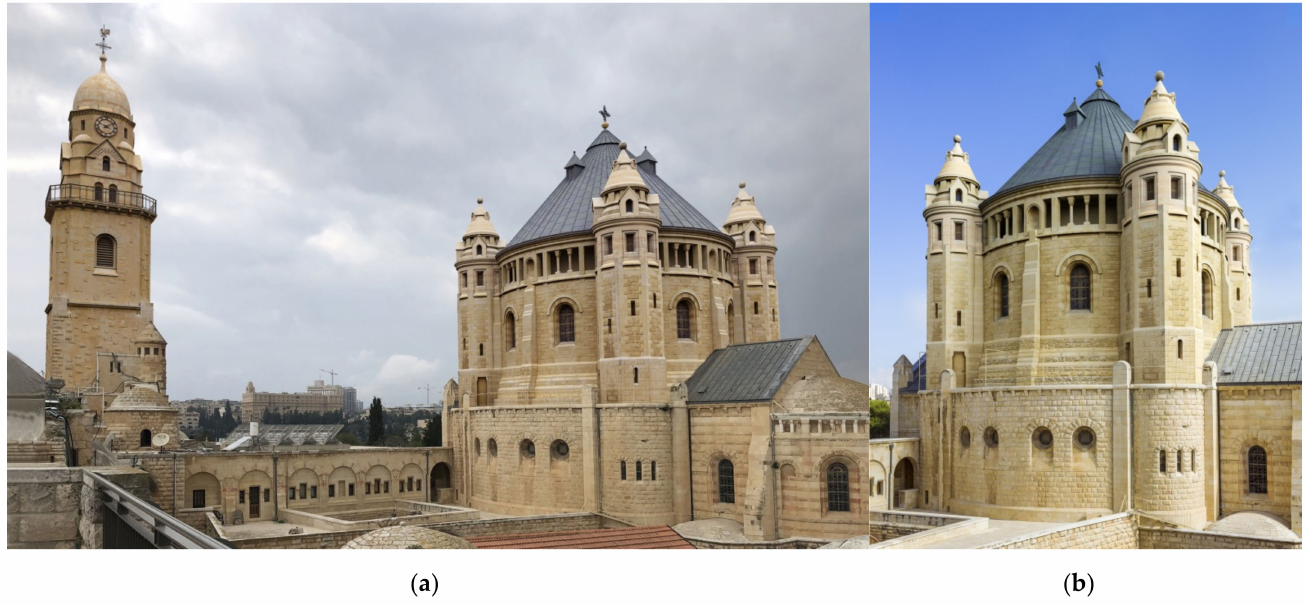
Figure 15. A collage of the basilica daytime photograph with its visualisation based on the geometric model under the same lighting conditions for ( a ) an overcast sky and ( b ) a clear